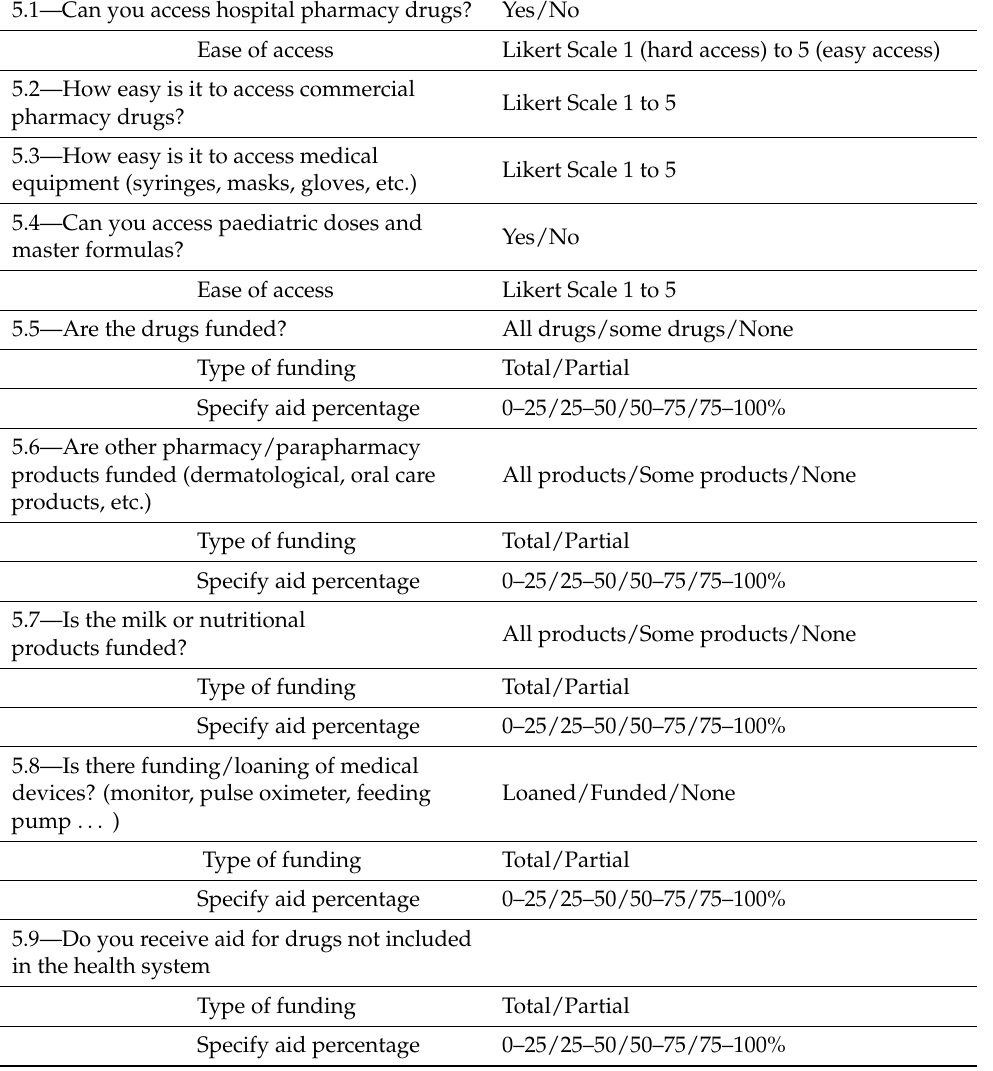
Table 2. Questions of Section 5—Drugs, pharmaceuticals and medical devices of the Social Resource